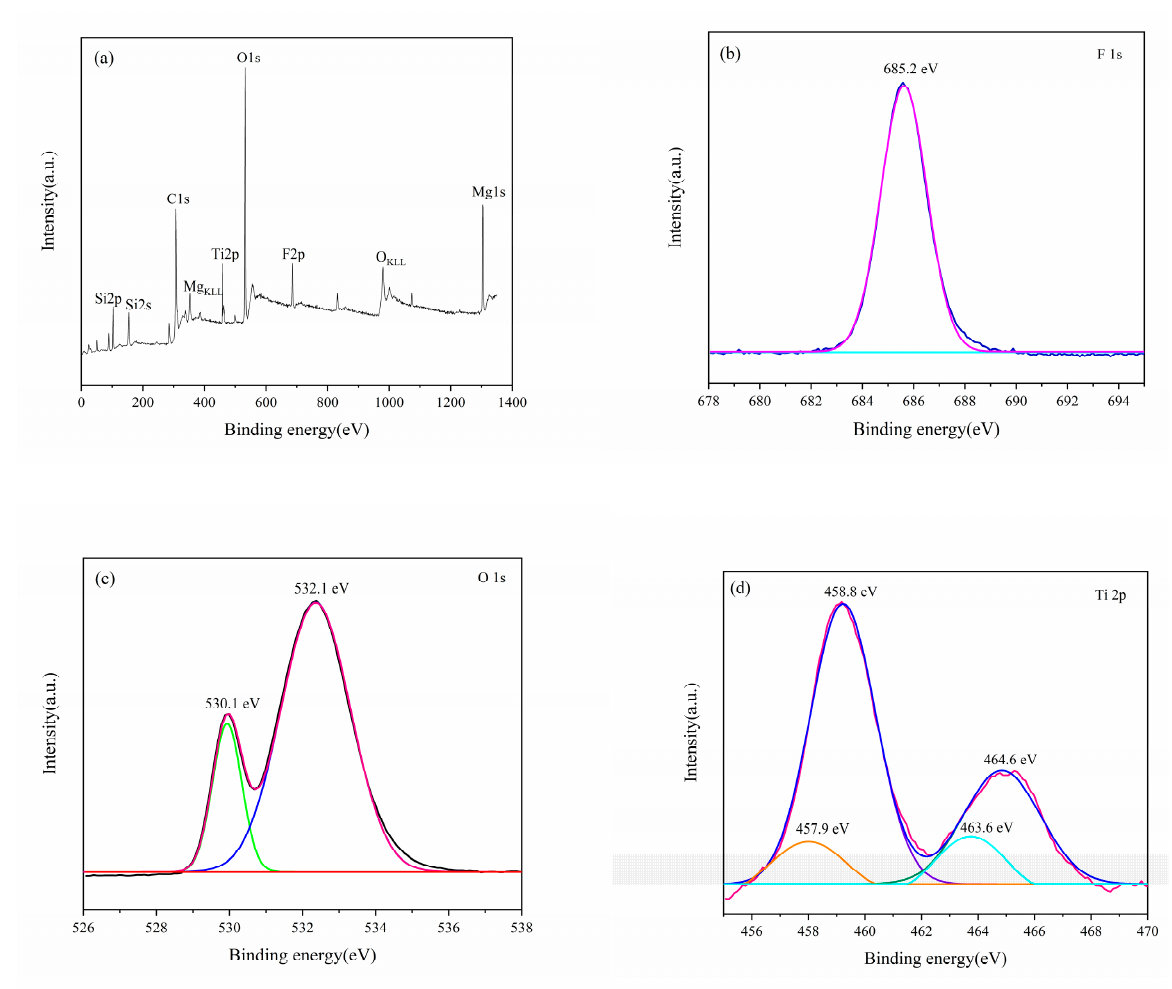
Figure 7. XPS spectra of TH-2 composite sample: ( a ) survey spectrum, ( b ) F 1s, ( c ) O 1s, and ( d ) Ti 2p. The presence of a peak of F 1s for TH-2 with a binding energy at 685.2 eV is shown in Figure 7b, which is associated with the physical surface adsorption of F [34]. The UV-Vis DRS of TH-2 exhibits intense absorption in the UV region without an obvious redshift, doping of the F element may contribute to the formation of oxygen